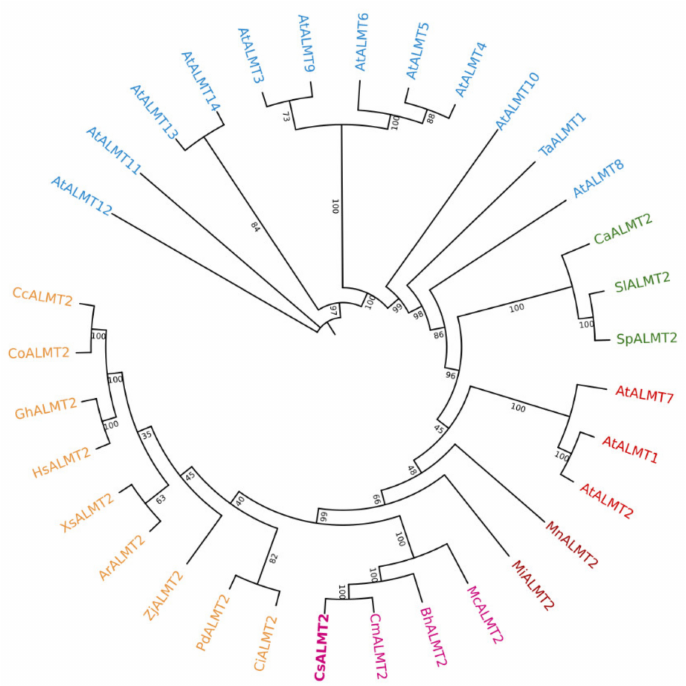
Figure 5. Phylogenetic analysis of CsALMT2. ALMT2 protein in different species and phylogenetic tree of other members of the ALMT family in Arabidopsis . The phylogenetic tree is generated using the maximum likelihood method in Omicshare Tools online software, and the inferred phylogeny is tested through the guided analysis of 1000 duplicate datasets. The number displayed at the tree fork represents the frequency of occurrence in all boot iterations